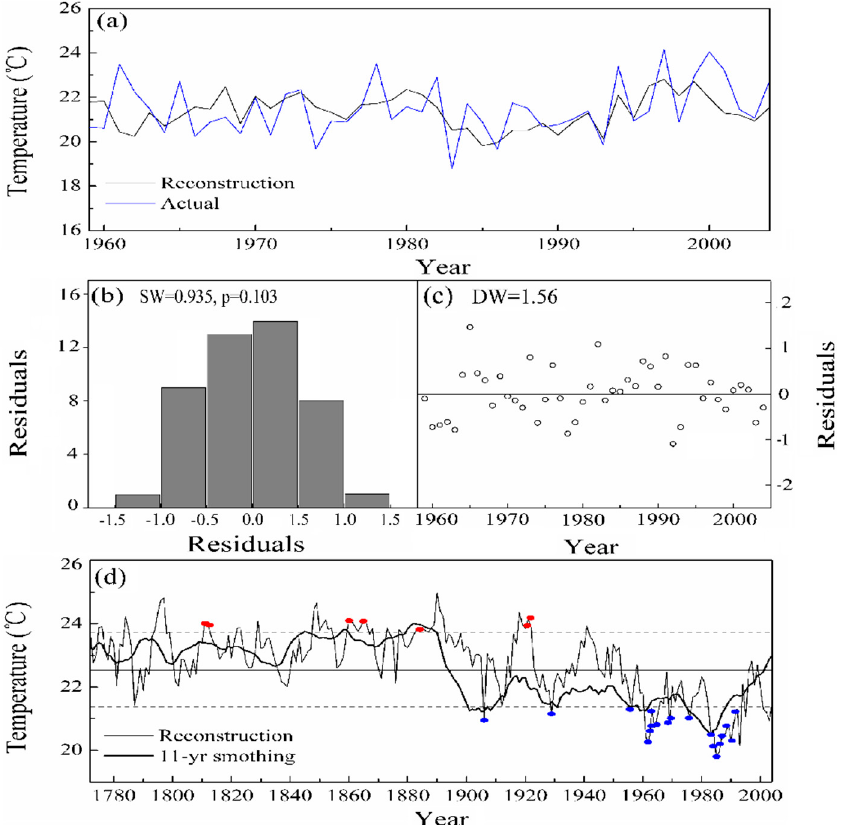
Figure 6. ( a ) Observed (blue line) and reconstructed (black line) Tmax6–7 for the common period of